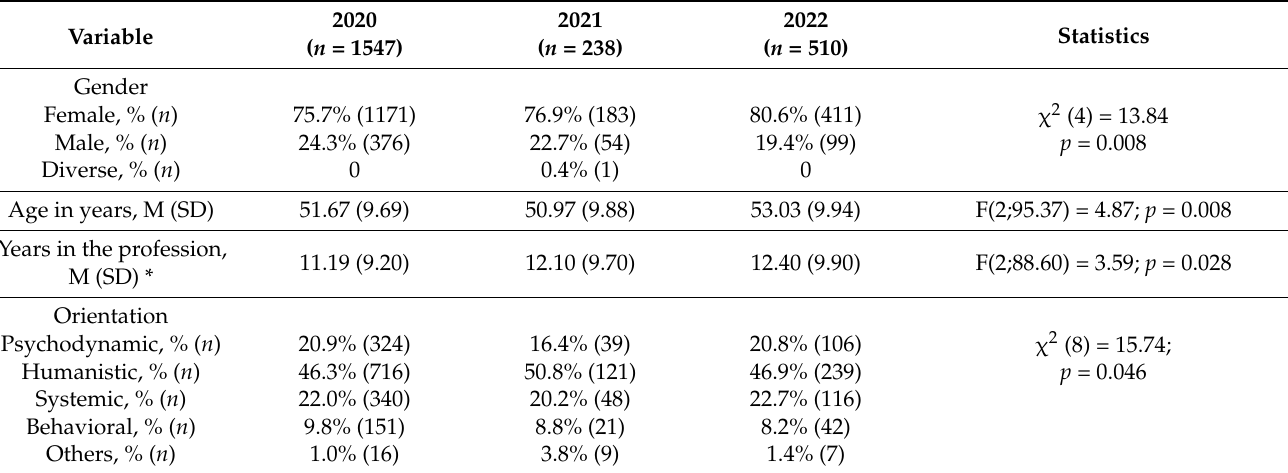
Table 1. Study sample